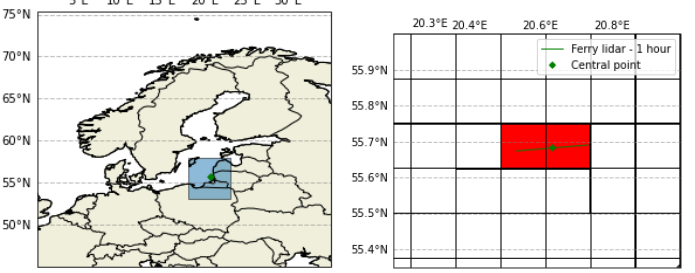
Figure 1. Left : Position of point in Europe. Right : ASCAT grid cell pair and corresponding 1 h of the ferry lidar path on 2 September 2017.